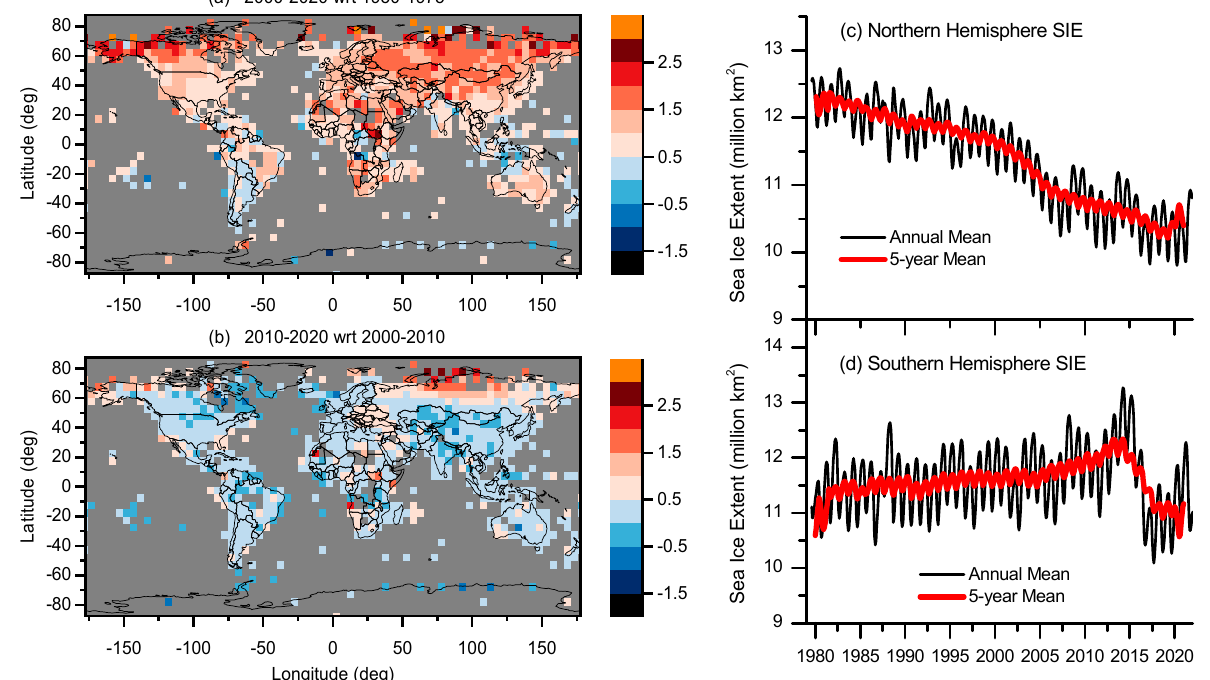
Figure 3. ( a , b ): Maps for global land surface air temperature differences of 2000–2020 minus 1950– 1975 and 2010–2020 minus 2000–2010. ( c , d ): Time series sea ice extent (SIE) in the Southern Hemi- sphere (SH) and Northern Hemisphere (NH) during